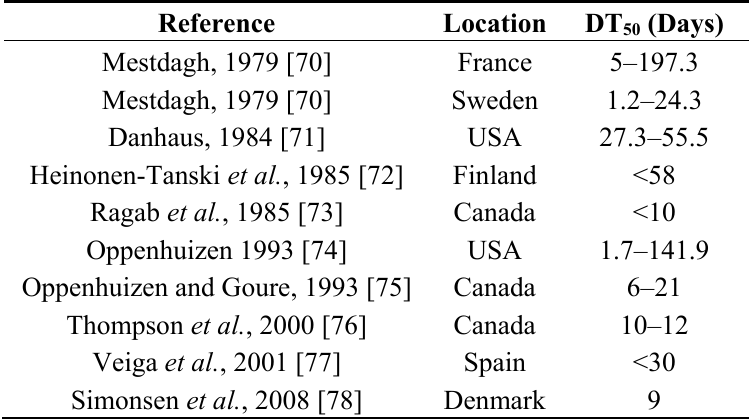
Table 4. Summary of glyphosate degradation times in agricultural soils as reported in the literature. DT 50 refers to the time required for 50% dissipation